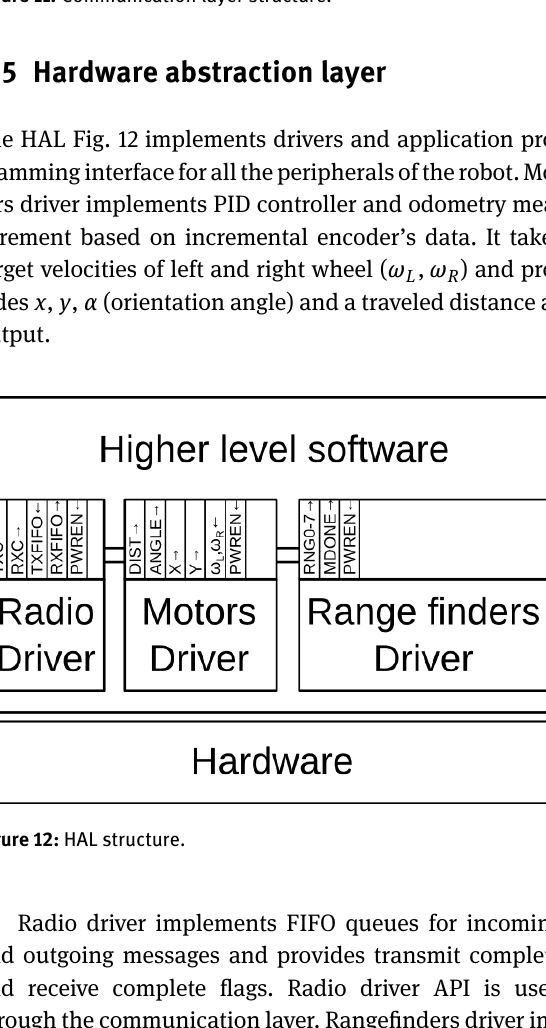
Figure 11: Communication layer structure.